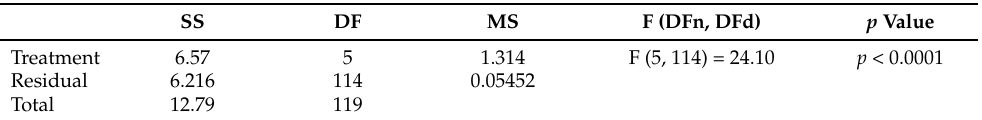
Table 11. Results of the ANOVA test for time and fitness convergence analysis of the parameters of DTO algorithm.